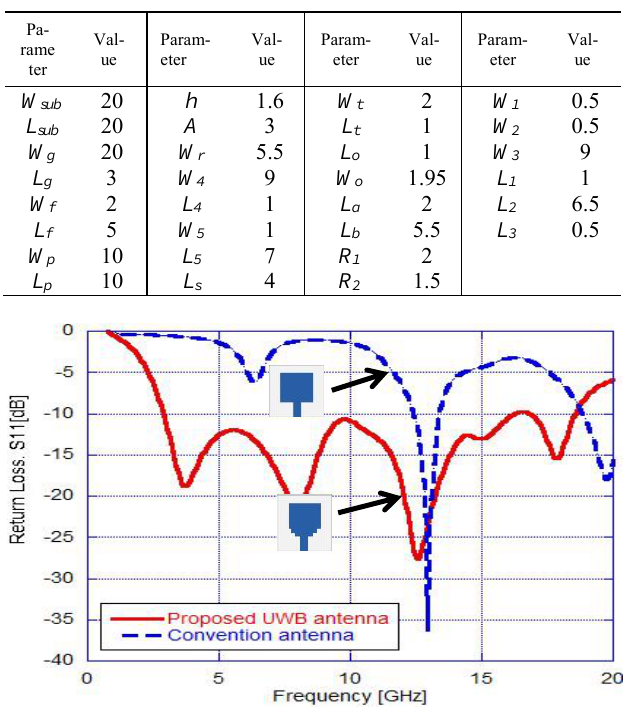
Figure 2: The proposed antenna versus conventional one.